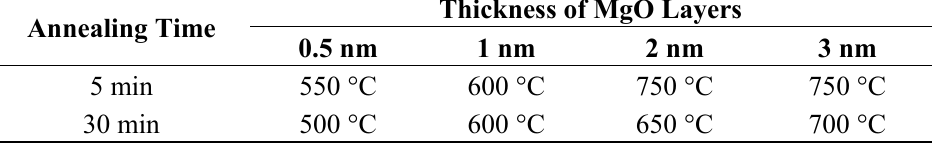
Table 1. Maximum annealing temperatures for various structures with low sheet resistance after